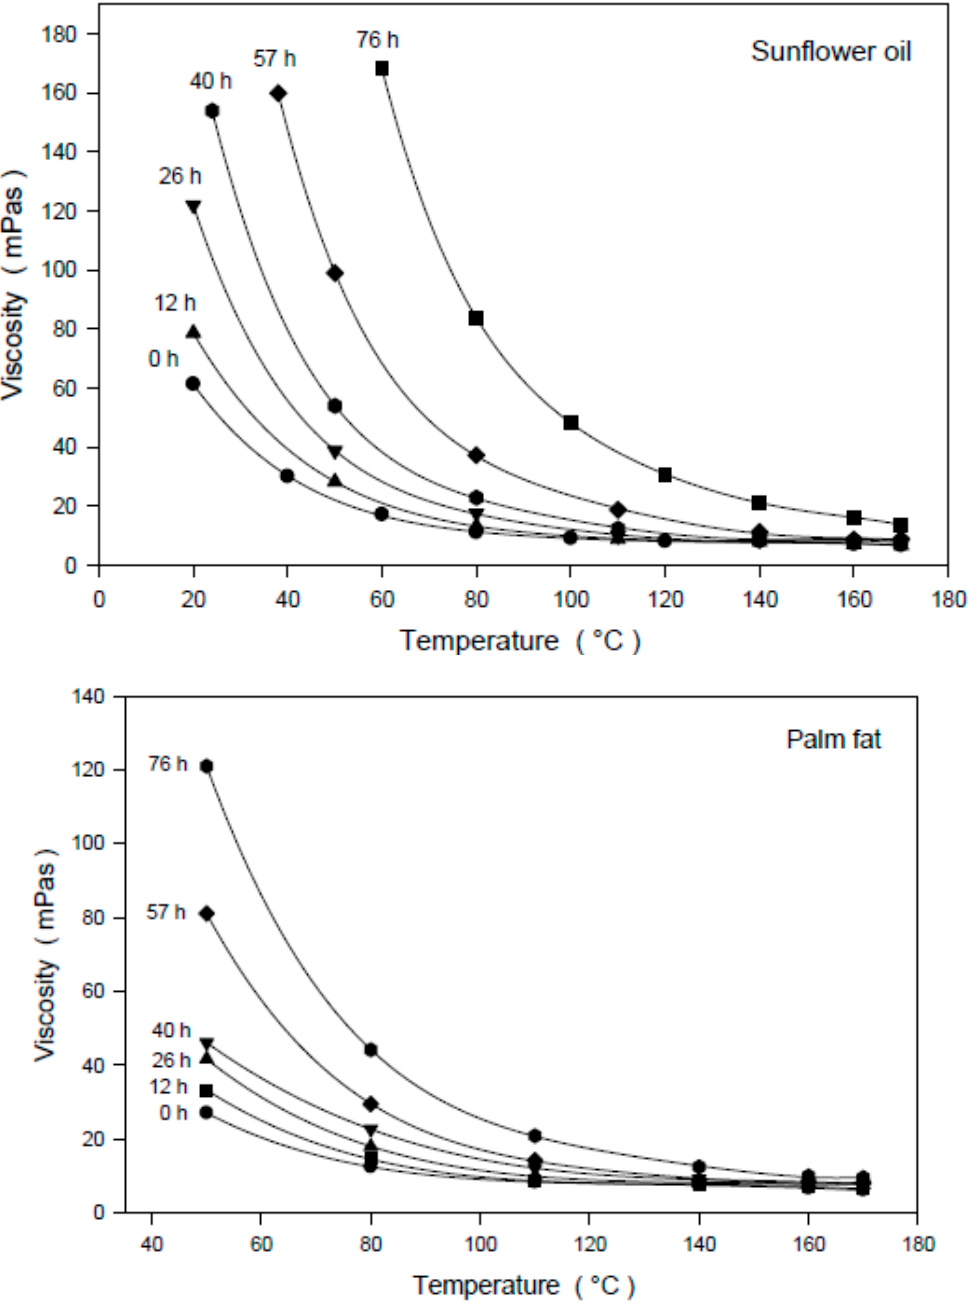
Figure 1. Dependence of dynamic viscosity of thermo-oxidatively treated sunflower oil and palm fat on the measuring temperature; treatment: 0–76 h at 175 ± 3 °C; normal atmosphere; shear rate: 1872 s − 1 ; parameter: thermal treatment time.